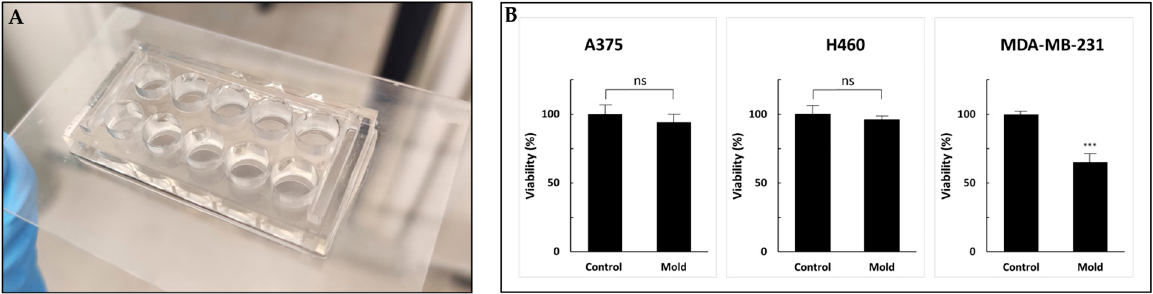
Figure 8. Cell viability (WST-1 cell proliferation assay) to test resin biocompatibility. ( A ) A 96-well design printed on a glass slide. ( B ) A375, H460 and MDA-MB-231 cells were incubated for 72 h followed by the addition of WST-1 reagent. Cell viability was not altered in A375 and H460 cell lines compared with MDA-MB-231 cells that exhibited a statically significant reduction. Values are expressed as means ± standard deviation (SD; n = 10). p < 0.001 was considered statistically significant and marked with an asterisk. ns: not significant, ***: